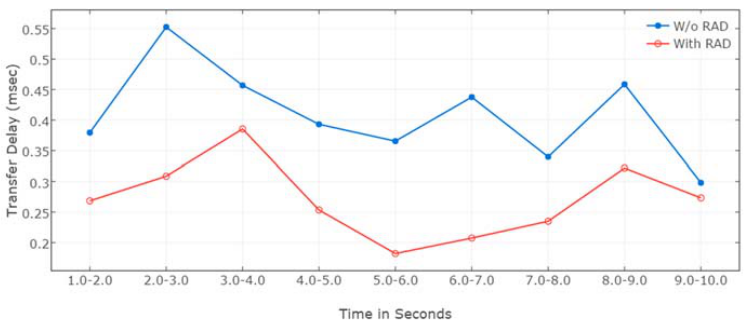
Figure 9. UDP transfer delay in simulation time (With attack in 1000 μ s intervals).